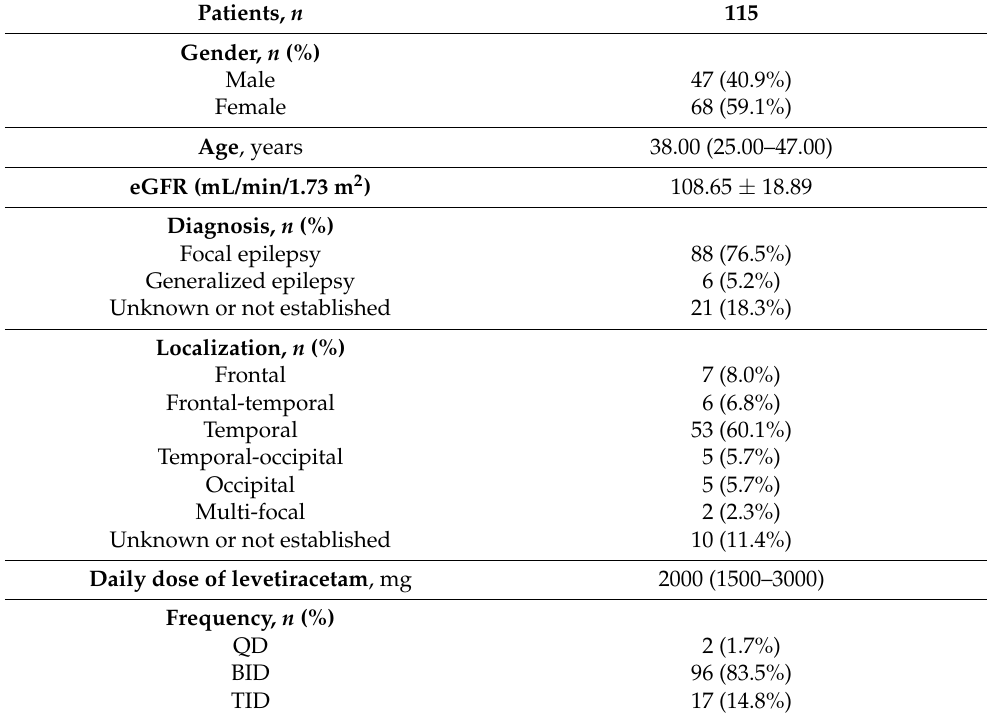
Table 1. Summary of the demographic and clinical characteristics of the population under